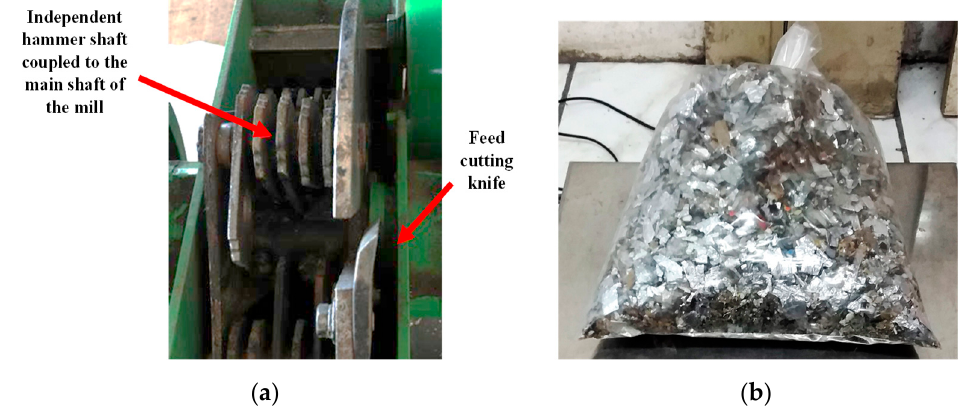
Figure 3. ( a ) Detail of the mill shafts. ( b ) Collected aluminum-containing thin sheets.